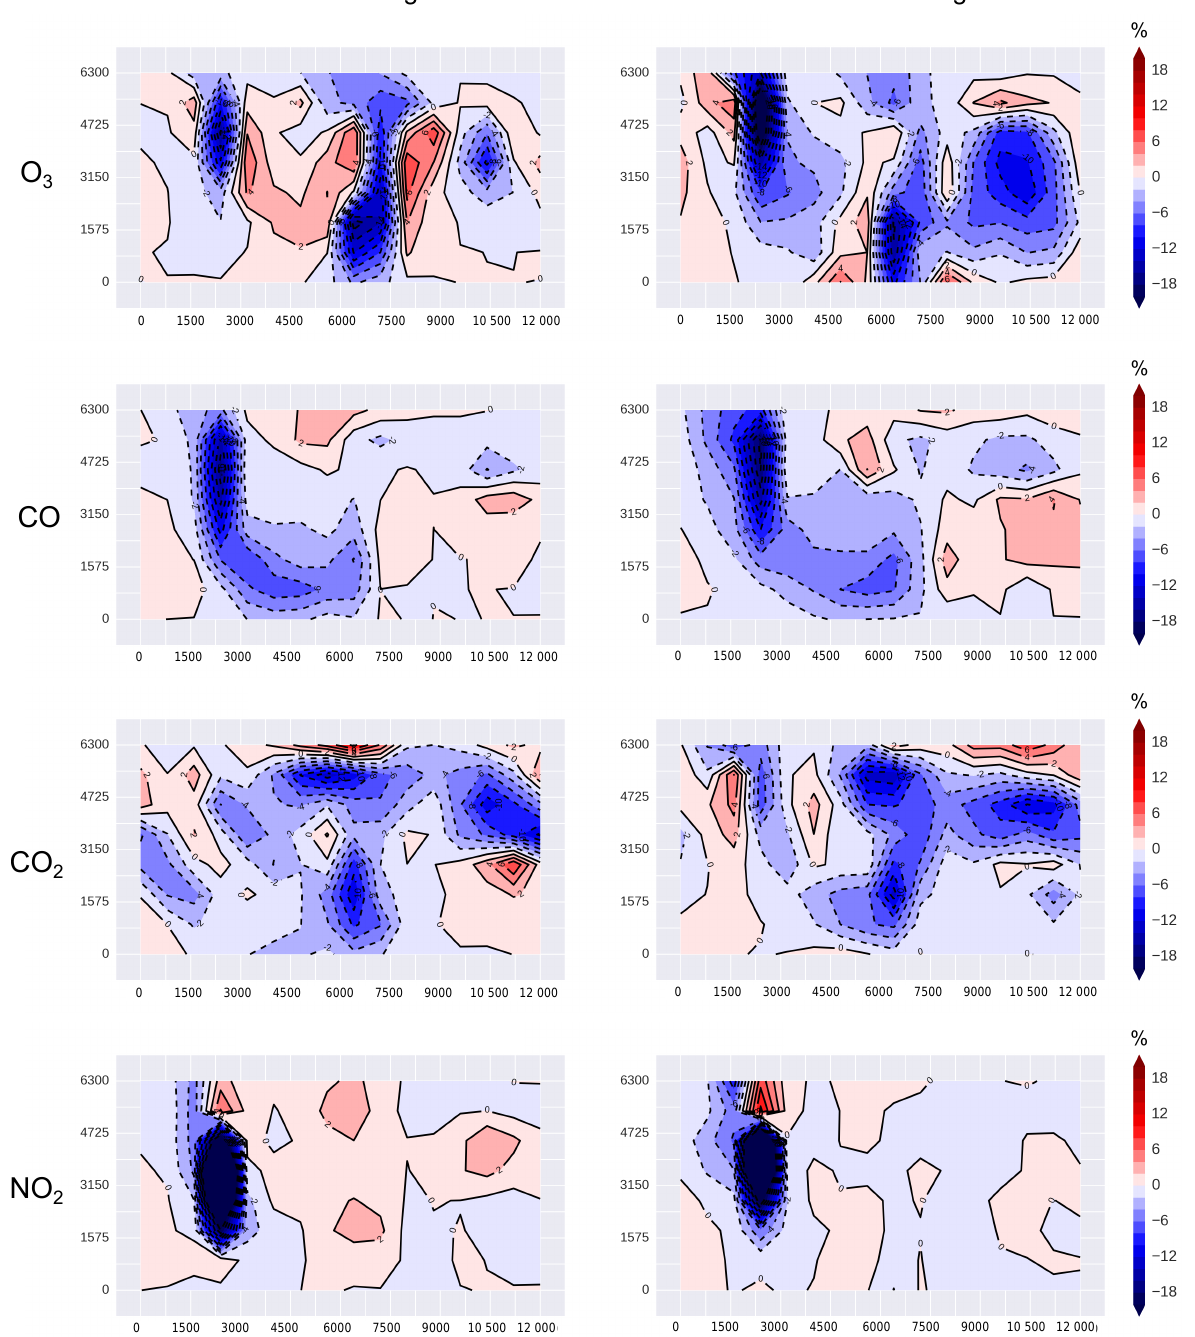
Figure 4. DA results with a perfect model hypothesis. From top to bottom: the RMSE gain (Eq. 18) is displayed, respectively, for O 3 , CO, CO 2 and NO 2 assimilation experiments. Blue color means that DA lowered the RMSE and red color means that DA increased the RMSE. Plots on the left are obtained using 3D-Var, on the right using